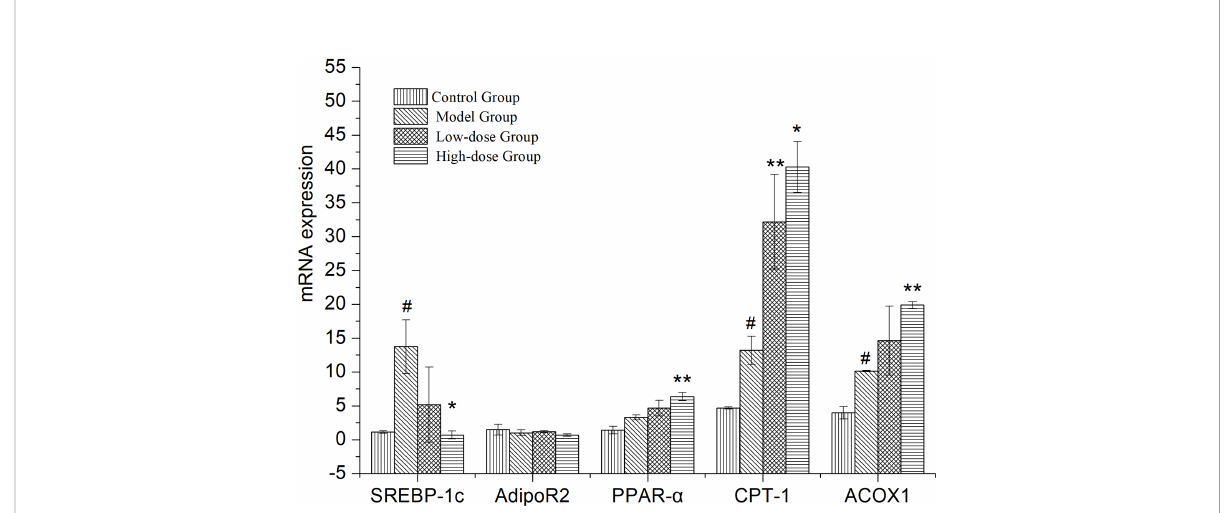
FIGURE 4 Effects of EMZAP on the expressions of relevant genes in the mice liver (n = 10) * P < 0.05 and ** P < 0.01 vs Model Group, # P < 0.05 and P < 0.01 vs Control